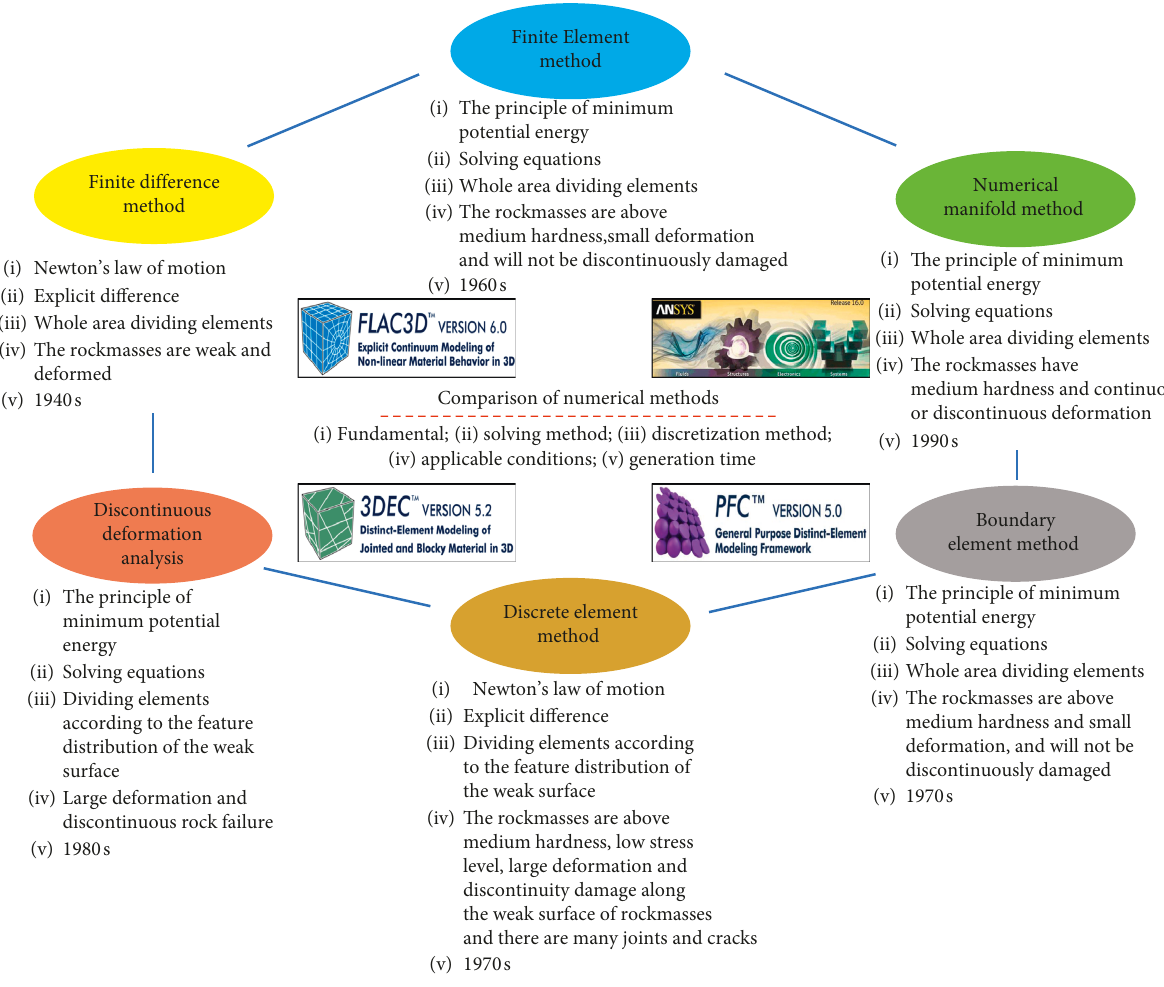
Figure 4: Comparison of several numerical simulation methods (revised from [107]).